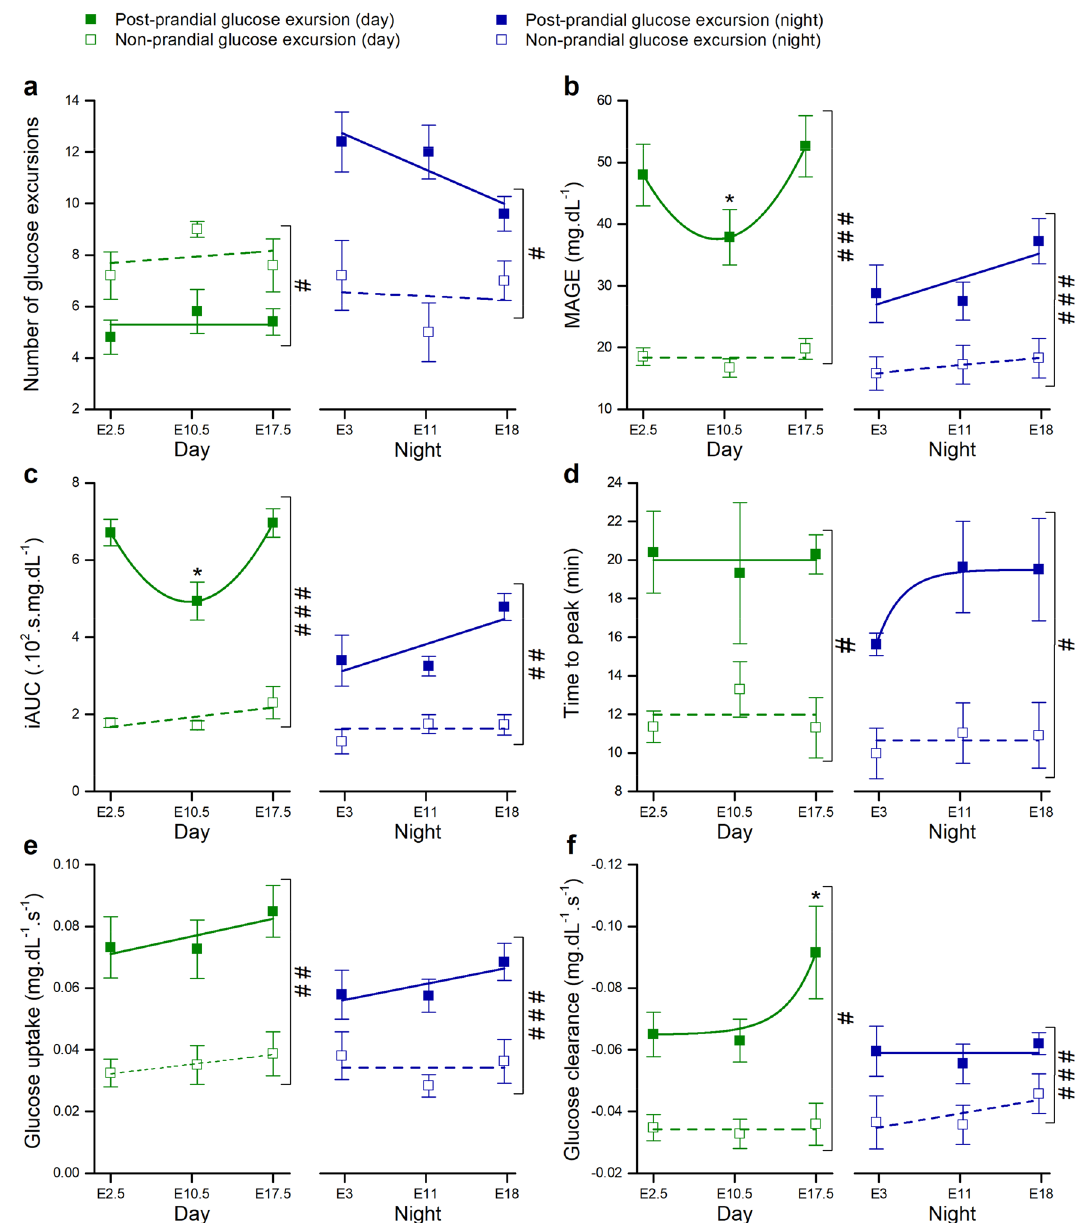
Figure 7. Characterization of post-prandial and non-prandial glucose excursions. Green: average over a day. Blue: average over a night. Closed squares: all post-prandial excursions of one day or night. Open squares: non-prandial excursions. ( a ) Mean number of blood glucose excursions ± s.e.m. ( b ) Mean amplitude of glucose excursions (MAGE) ± s.e.m.. ( c ) Arithmetic mean of incremental area under the curve (iAUC) ± s.e.m. of the glucose excursions. ( d ) Arithmetic mean of time to peak ± s.e.m. of the glucose excursions. ( e ) Arithmetic mean glucose uptake ± s.e.m. of the glucose excursions. ( f ) Arithmetic mean glucose clearance ± s.e.m. of the glucose excursions. Note the increased glucose clearance during the daytime from post-prandial excursions towards the end of the pregnancy. Data was compared within each group with repeated measures one-way ANOVA with Bonferroni post hoc pairwise comparison after a Shapiro–Wilk normality test confirmed normal distributed data. *: P < 0.05, n = 5 mice per group. Comparison between post-prandial and non-prandial events at the same time was done with a two-way repeated measures ANOVA and significances are indicated as # < 0.05, ## < 0.01, ### < 0.001. For clarity, the data in this figure is also shown in the supplementary information in Table S1. See also supplementary Fig.